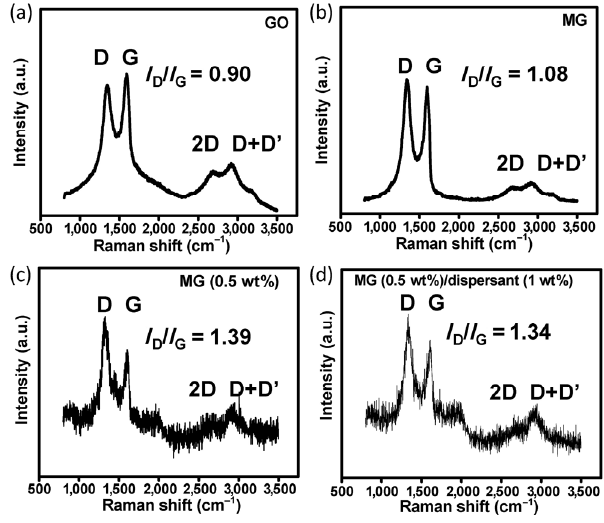
Fig. 6 Raman spectra of (a) GO, (b) MG, (c) wear track for PAO-6 with MG on steel plate and (d) PAO-6 with MG/dispersant on steel